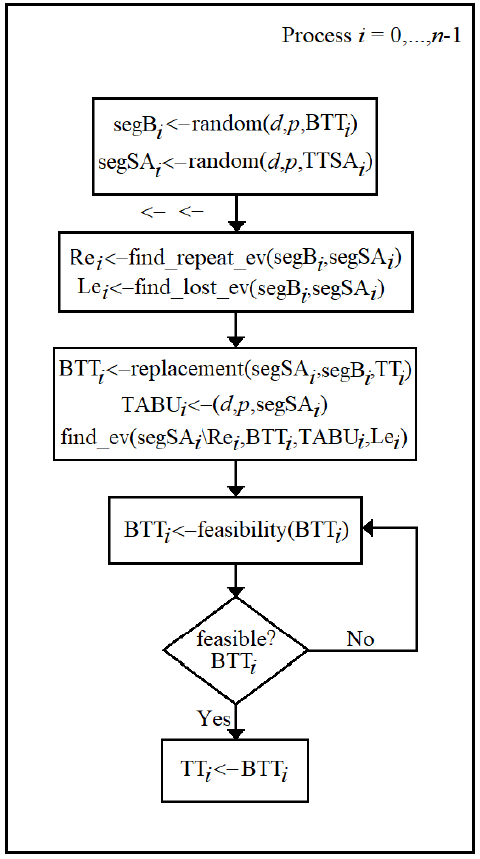
Figure 3. Processes cooperation procedure, TTi = cooperation (BTTi, TTSAi).